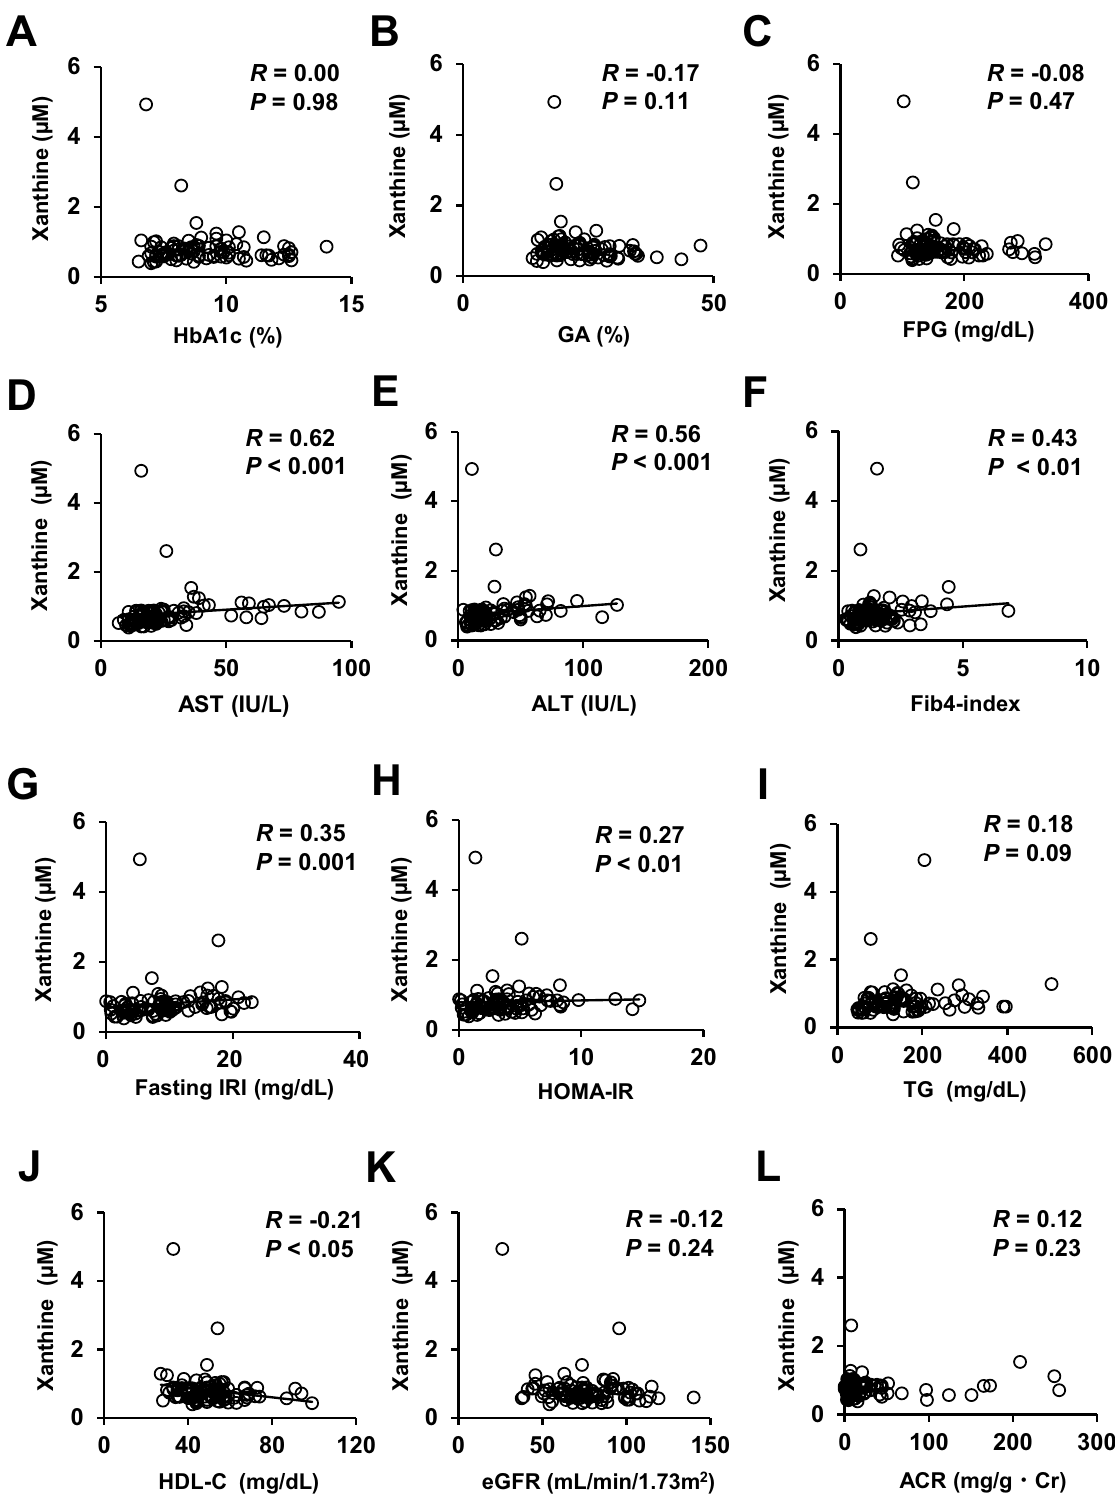
Figure 3. Correlations between the plasma xanthine level and clinical parameters. Correlations between the plasma concentration of xanthine (µM) and ( A ) HbA1c (%), ( B ) glycated albumin (%), ( C ) fasting plasma glucose level (mg/dL), serum levels of ( D ) AST (IU/L) and ( E ) ALT (IU/L), ( F ) Fib4-index, ( G ) fasting serum IRI (µU/mL), ( H ) HOMA-IR, ( I ) serum TG level (mg/dL), ( J ) HDL-C (mg/dL), ( K ) eGFR (ml/min/1.73m 2 ), and ( L ) urinary albumin to creatinine ratio (ACR) (mg/g ·